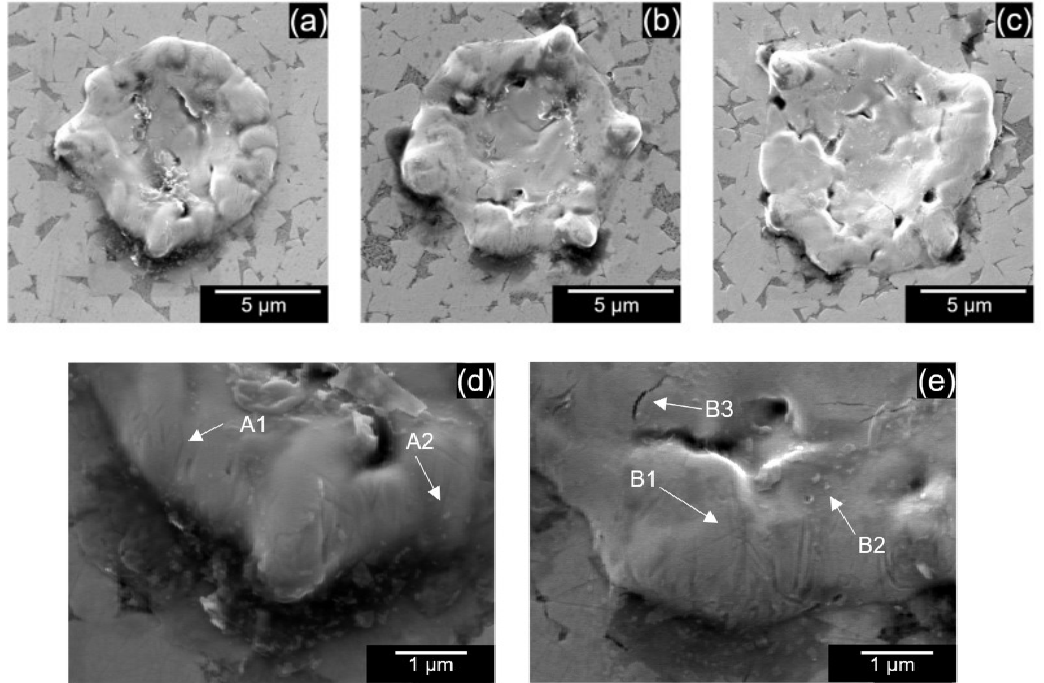
Figure 5. Single discharge craters for ( a ) 90 V, ( b ) 100 V, ( c ) 110 V using EDM oil without powder addition. Crater edge at ( d ) 90 V, ( e ) 100